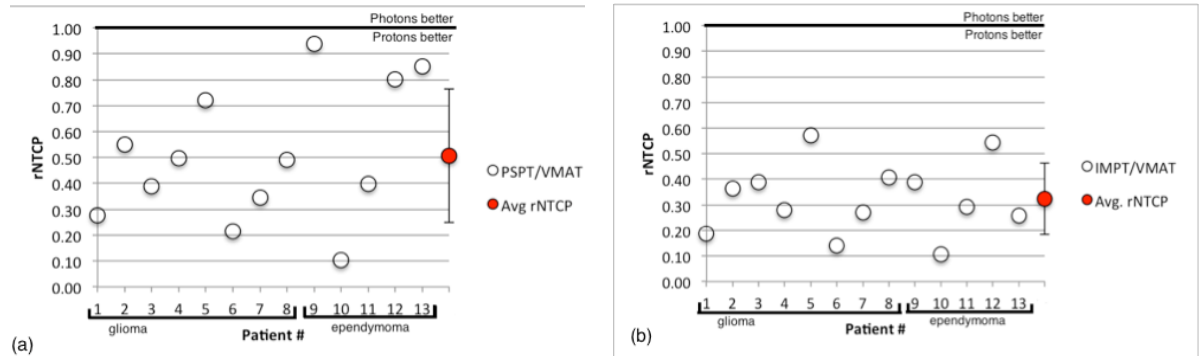
Figure 6. ( a ) The ratio of risk (rNTCP) for PSPT plans compared to VMAT for all patients. ( b ) The ratio of risk (rNTCP) for IMPT plans compared to VMAT for all patients. The average value of rNTCP represented by the red circle with standard deviation error